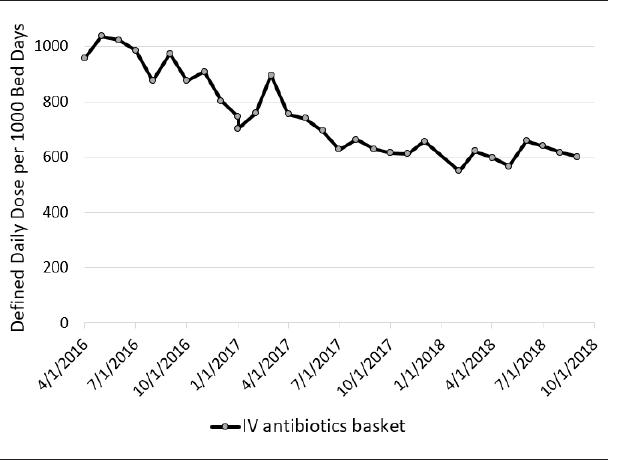
Figure 2a: Overall Antibiotic Usage During the Post-BB and ASP period